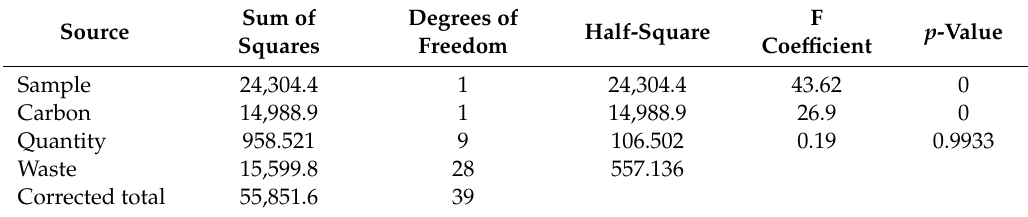
Table 4. Results of analysis of variance for color removal efficiency.